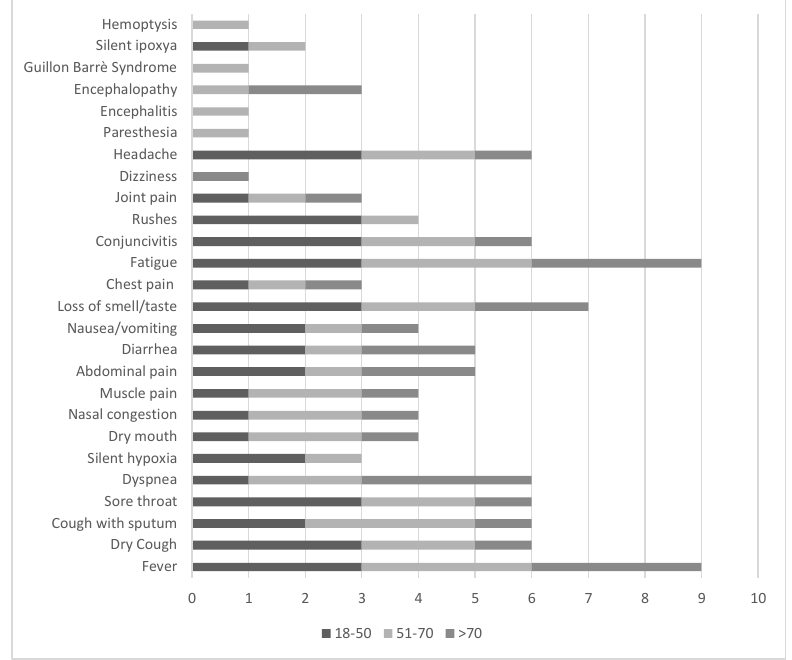
Figure 2. Frequency of COVID-19 clinical features divided into age groups (scale: 0 – 3; 0 = not observed, 3 = frequently observed).